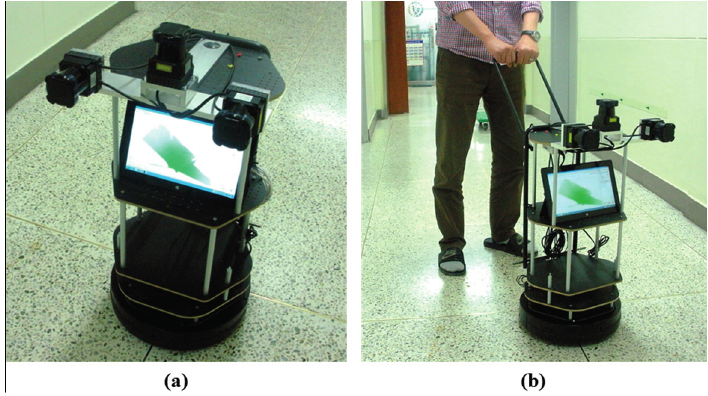
Figure 6. ( a ) Kinematic 3D laser scanning system and ( b ) system